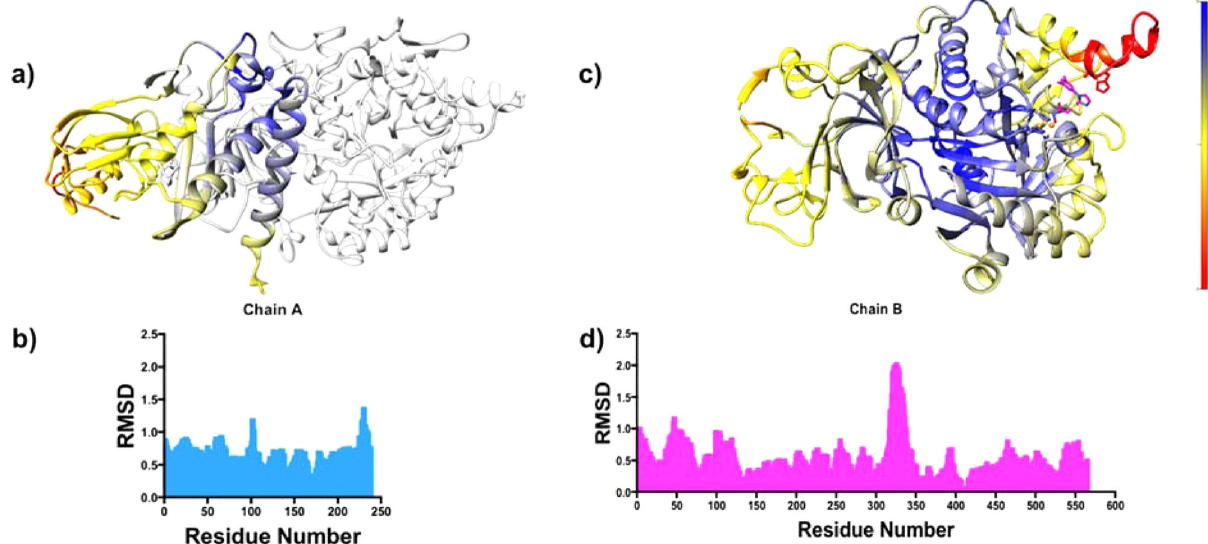
Fig. 4 Backbone RMSD between U-BME and U-SHA. a UreA backbone RMSD with chain B for reference in light gray (gradient of high, medium, and low RMSD values in a gradient of red, yellow and blue). b Histogram of UreA per residue RMSD distribution. c UreB backbone RMSD (gradient of high, medium, and low RMSD values in a gradient of red, yellow, and blue). d Histogram of UreB per residue RMSD